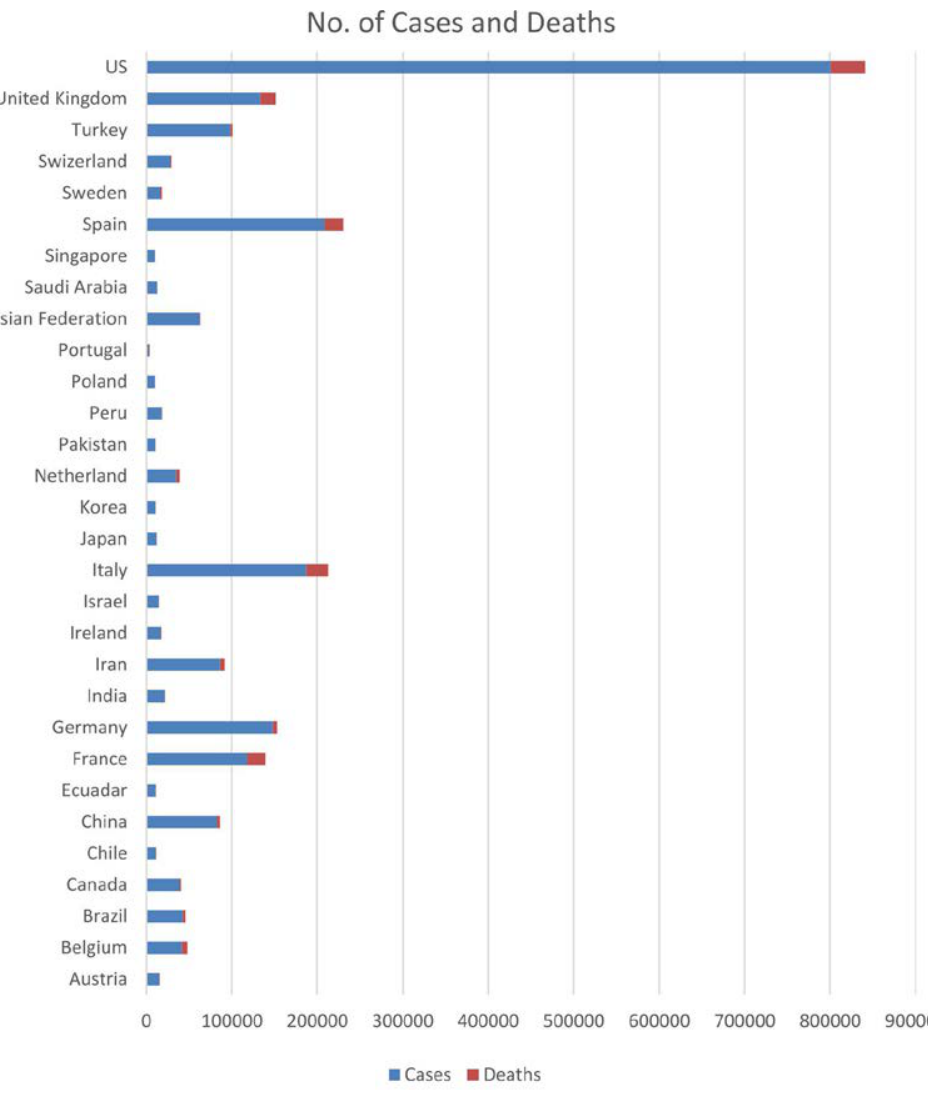
Fig. 3. Number of Cases and Deaths with COVID-19 in several